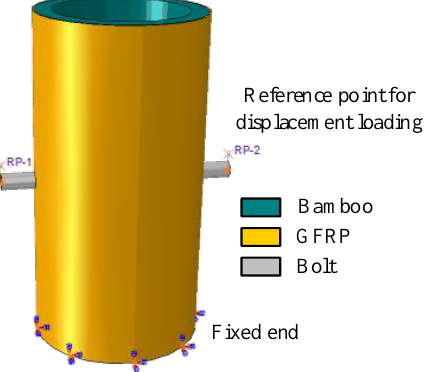
Figure 6. Boundary and loading conditions of simulation model.